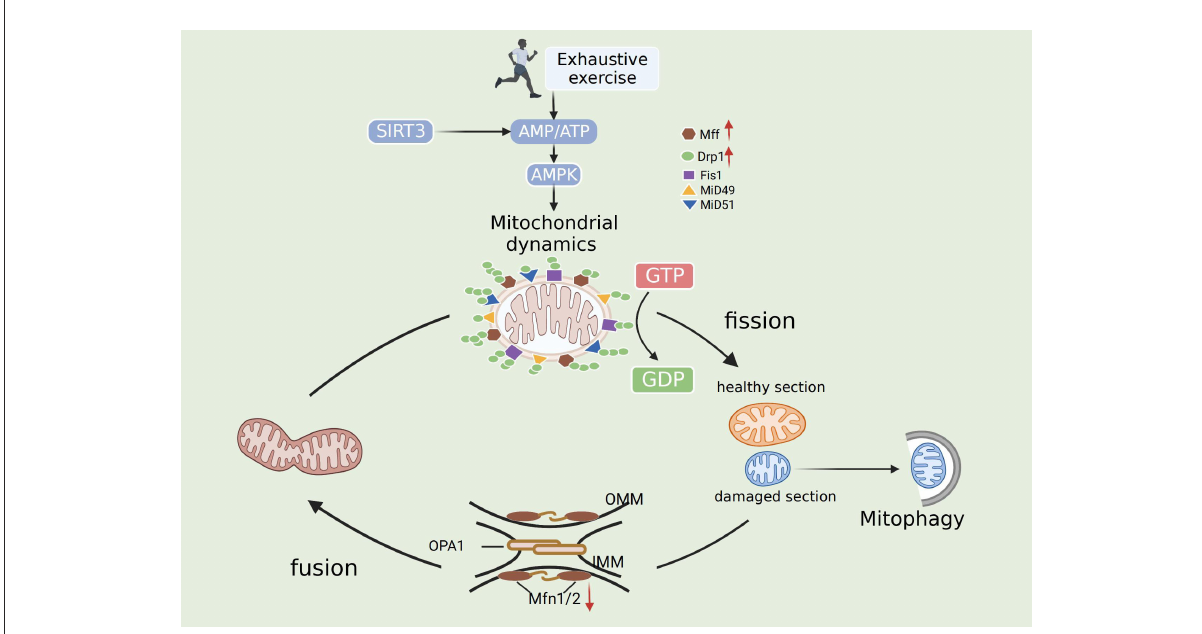
FIGURE2 Mechanisms of mitochondrial dynamics after exhaustive exercise. In general, fission is mediated by Drp1, Drp1 receptors (Mid 49, Mid51, Mff) and Fis1. Fusion is mediated by Mfn1, Mfn2 and Opa1. Fission and fusion machineries regulate mitochondrial by dislodging the damaged organelles. Exhaustive exercise disbalances mitochondrial fission and fusion, and the mitochondrial network is gradually impaired. The mitochondria undergo both symmetrical and asymmetrical fission. Symmetrical fission generates two “new” healthy mitochondria, whereas asymmetrical fission of mitochondria produces healthy and damaged sections. The healthy section fuses with other healthy organelles for regeneration. The damaged section can be cleared by autophagosomal engulfment, thereby protecting the cell from mitochondrial